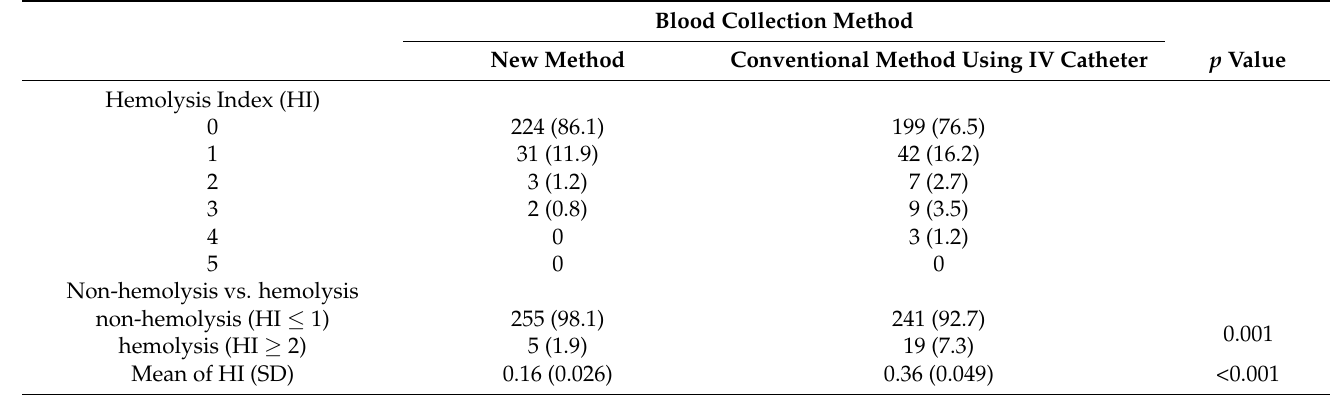
Table 2. Comparison of the hemolysis index between the new blood collection method and the conventional blood collection